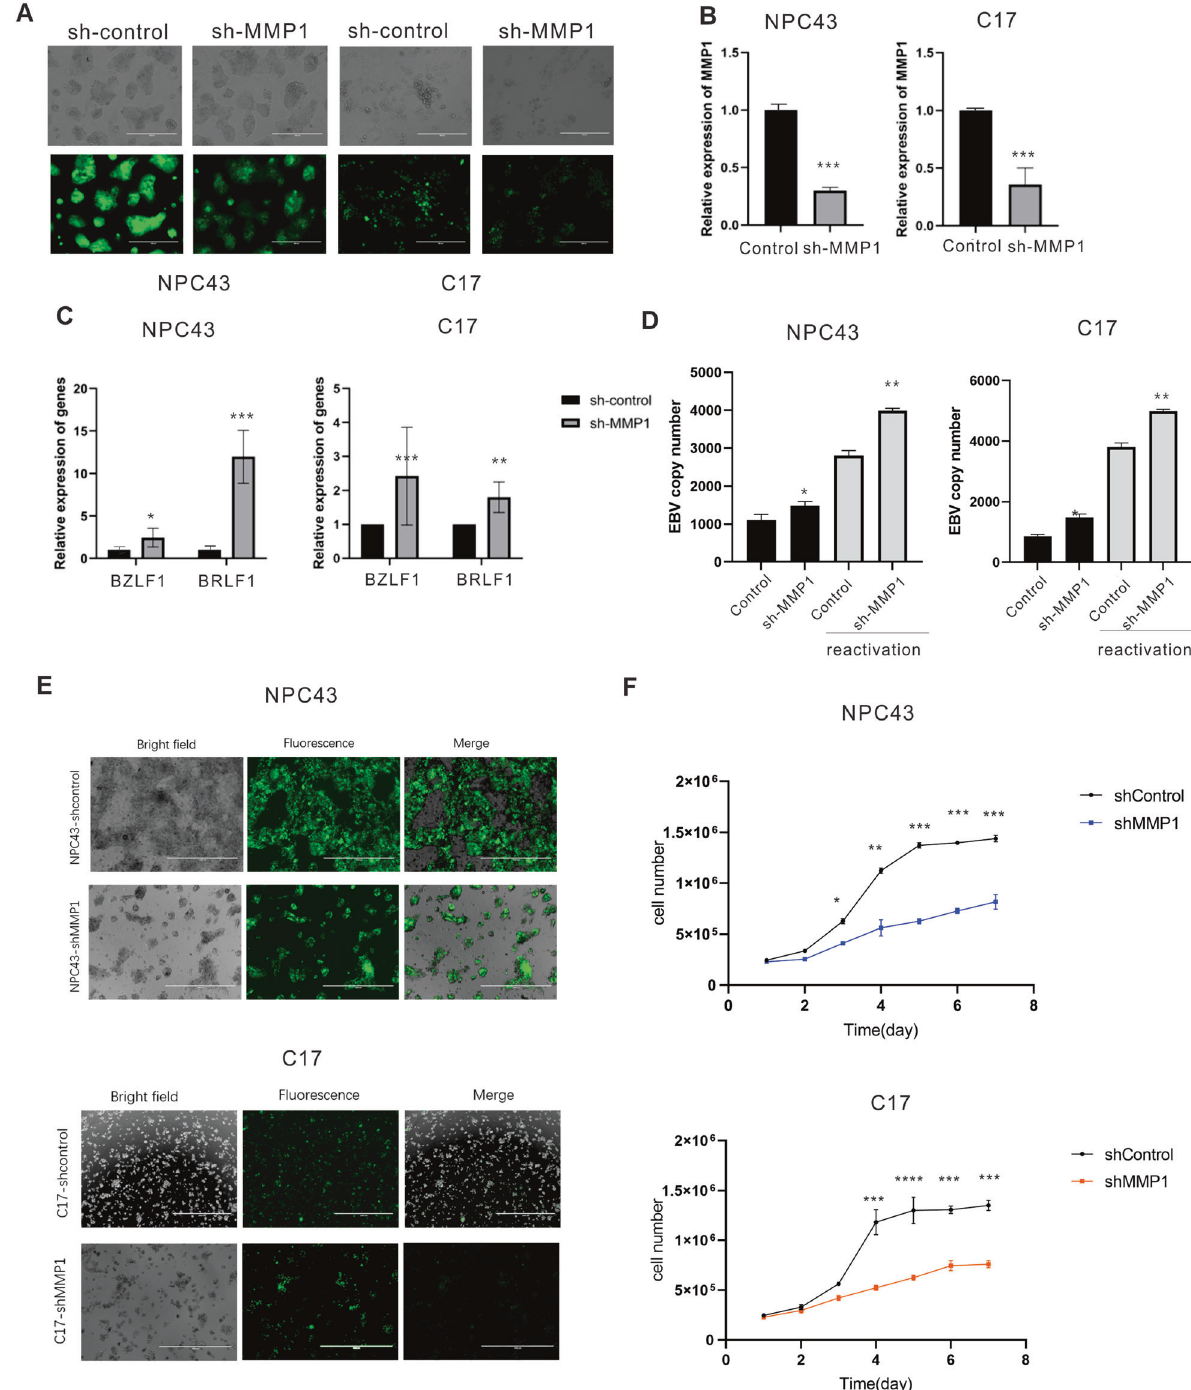
Fig. 6 MMP1 is important for maintenance of latent infection in epithelial cells. MMP1 restricts EBV lytic reactivation and provides growth- supportive properties in infected epithelial cell lines. A MMP1 knocked down NPC43 and C17 cells were constructed by lentiviruses and selected by puromycin for three weeks. GFP fl uorescence was determined in the selected cells. B The expression of endogenous MMP1 was determined by qRT-PCR. C Quanti fi cation of EBV lytic gene BZLF1 and BRLF1 mRNA from three experiments is shown. D Relative EBV-GFP DNA copy numbers were quanti fi ed as a measure of EBV load released from NPC43-shMMP1 and C17-shMMP1 before and after the reactivation with TPA and Butyrate. EBV DNA copy number was detected by real-time qPCR. E Cell proliferation fl uorescence microscopy images of NPC43- shControl, NPC43-shMMP1, C17-shControl and C17-shMMP1 after 5 days. F Cell growth curves of NPC43 and C17 cells determined by cell count after MMP1 knockdown at different days.